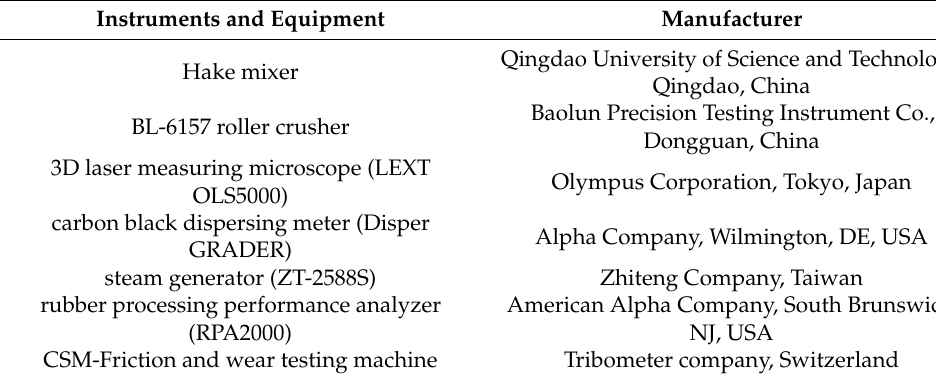
Table 1. Experimental instruments and equipment.